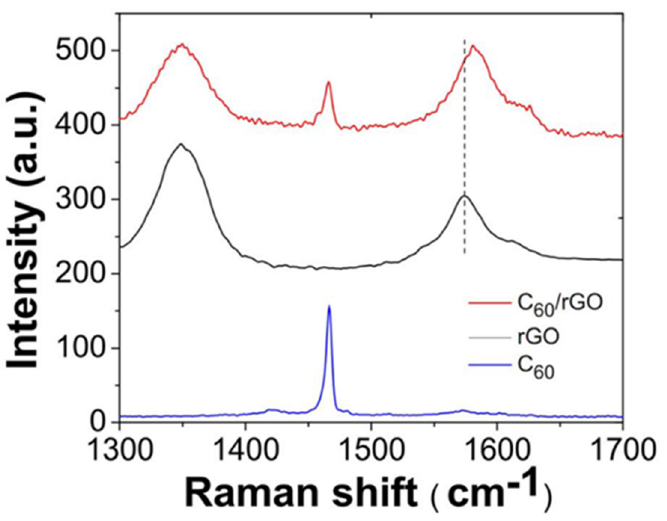
Figure 6. Raman spectra of C60, rGO and C60/rGO hybrid. Adopted from [152] (CC BY).